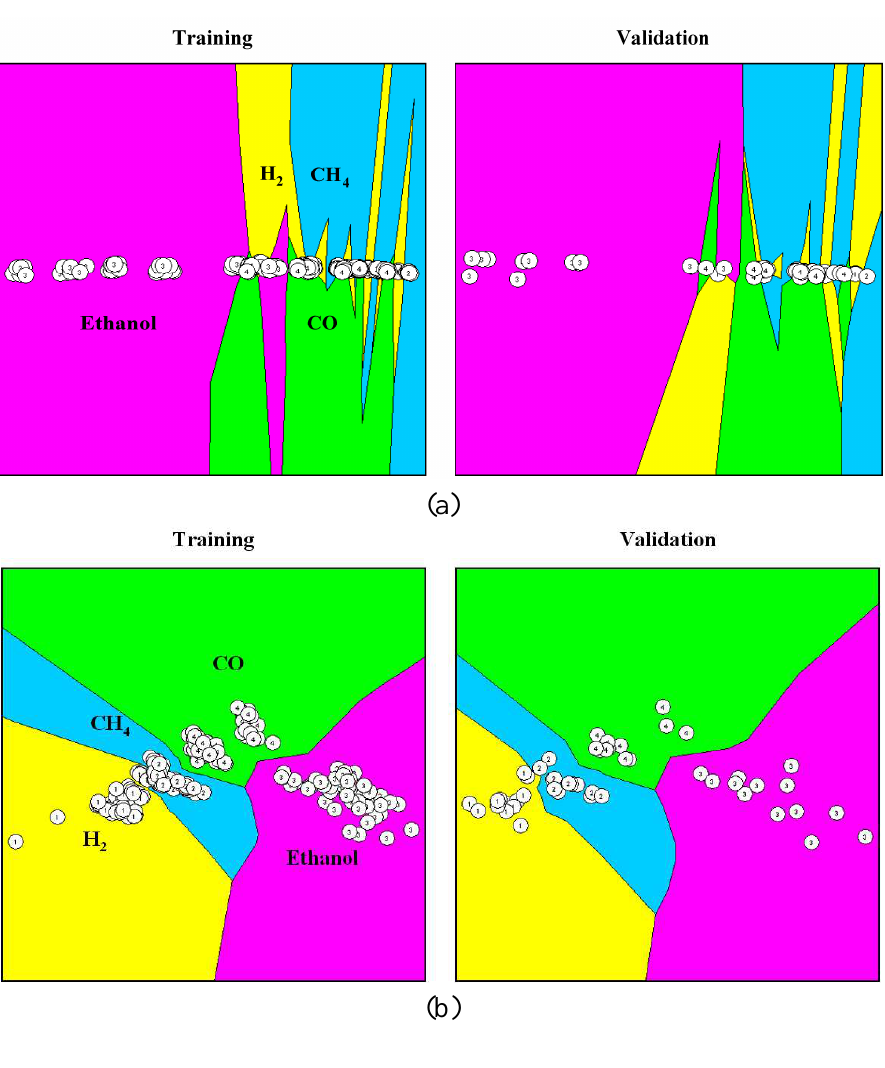
Figure 20. Visual inspection of four gases data: (a) raw sensor signals and (b) extracted by evolved Gaussian